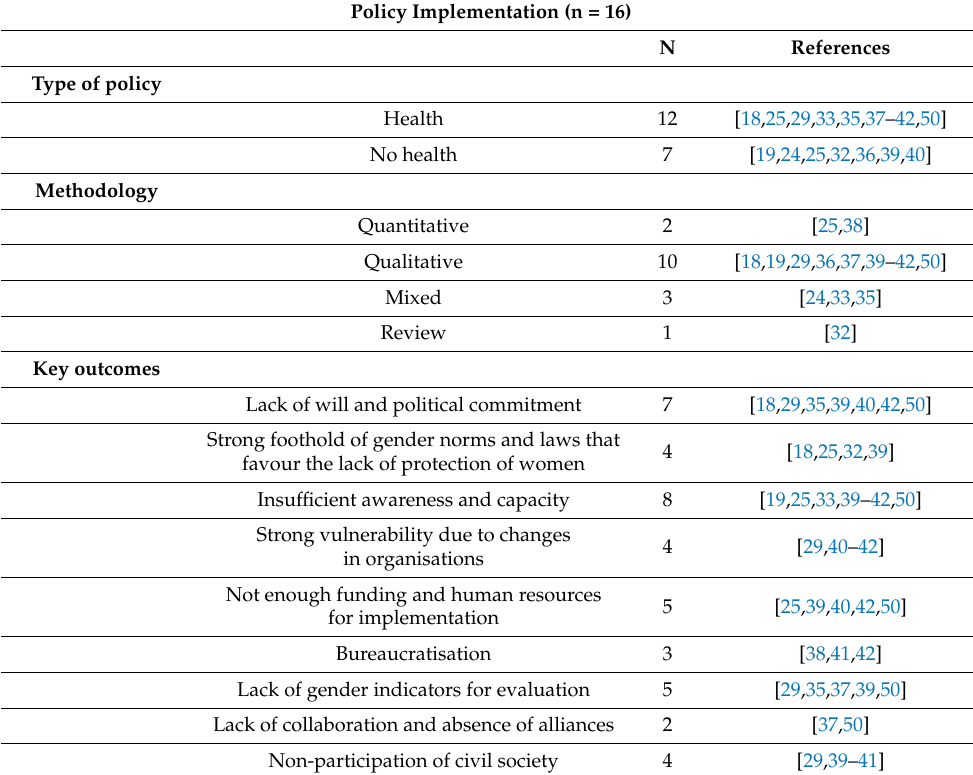
Table 2. Description of main characteristics and key outcomes of the 16 included papers analysing the implementation of policies aimed at reducing gender inequalities in